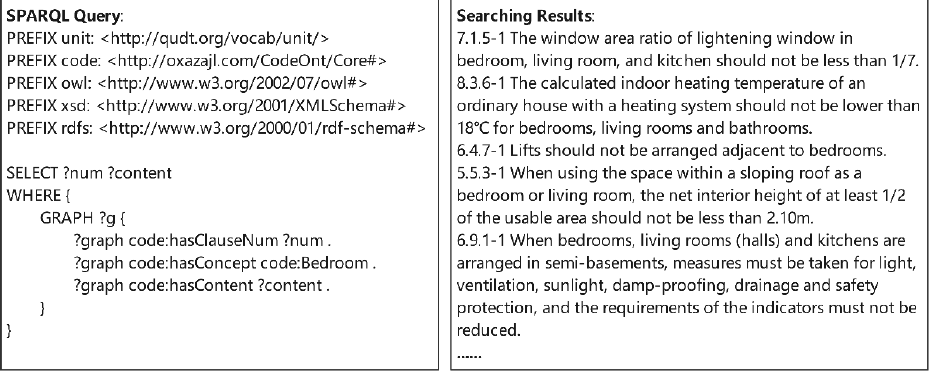
Figure 17. Part of the multiscale knowledge model for residential building design codes.